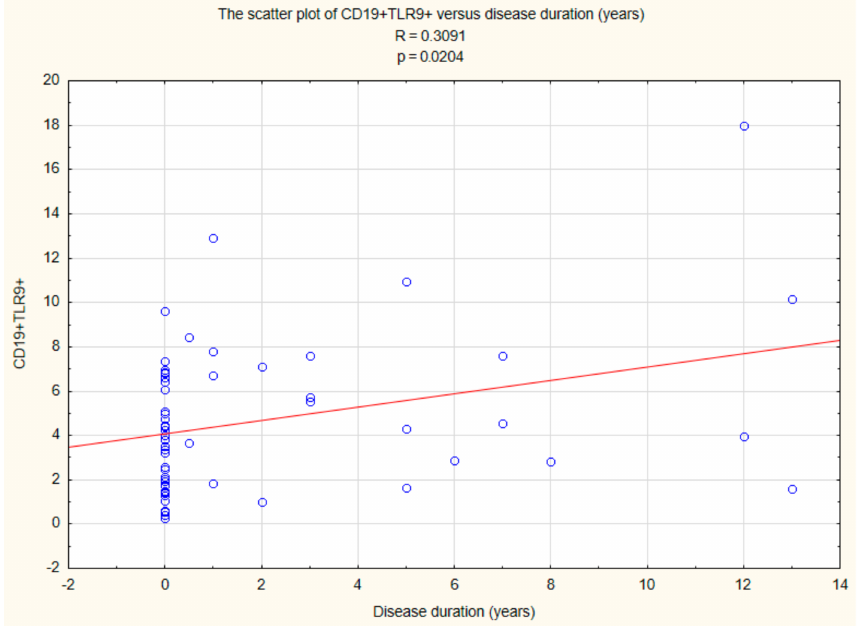
Figure 7. Relationship between CD19+ TLR9+ B cells and duration time after the onset of DM1. There was also a relationship between CD8+ TLR4+ T cells (R = 0.3081, p < 0.05) and duration time after the onset of DM1 (Figure